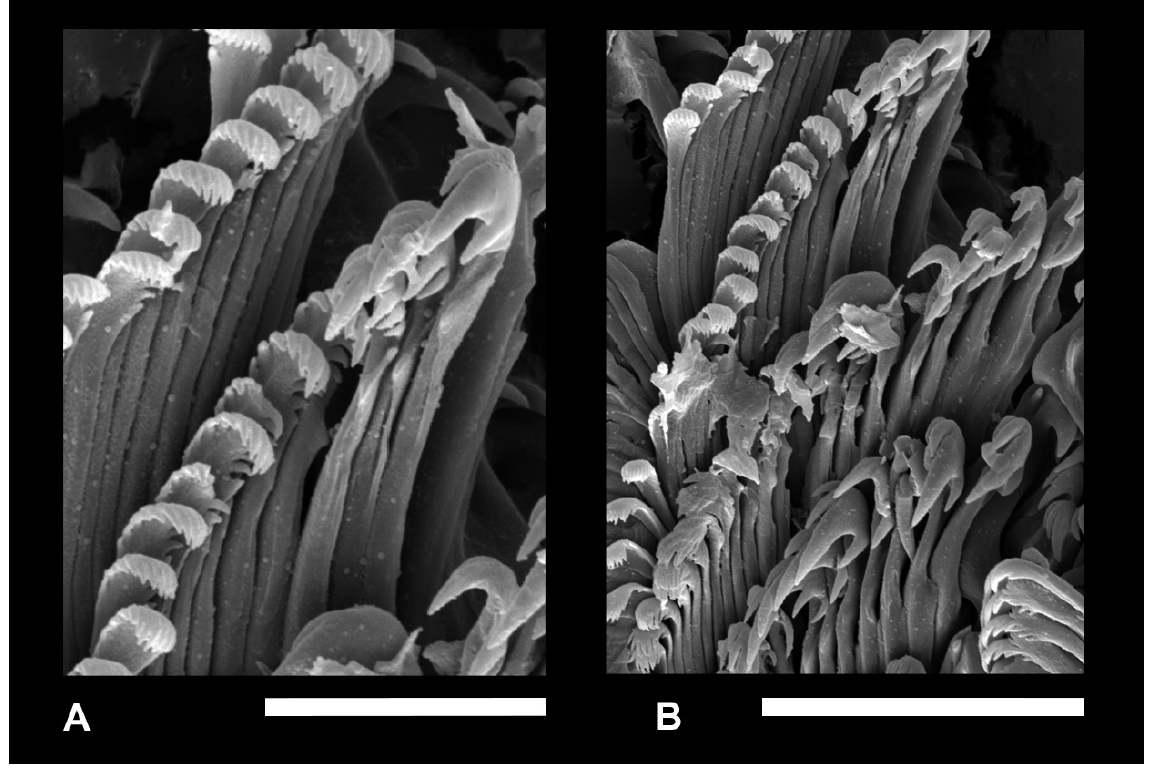
Fig. 7. Radula of Anatoma declivis sp. nov., South-East Indian Ridge, INDEX19_127RO, (I19_Ma_78). A . SEM image of distal marginal teeth. B . SEM image of proximal marginal teeth. Scale bars: 10 m